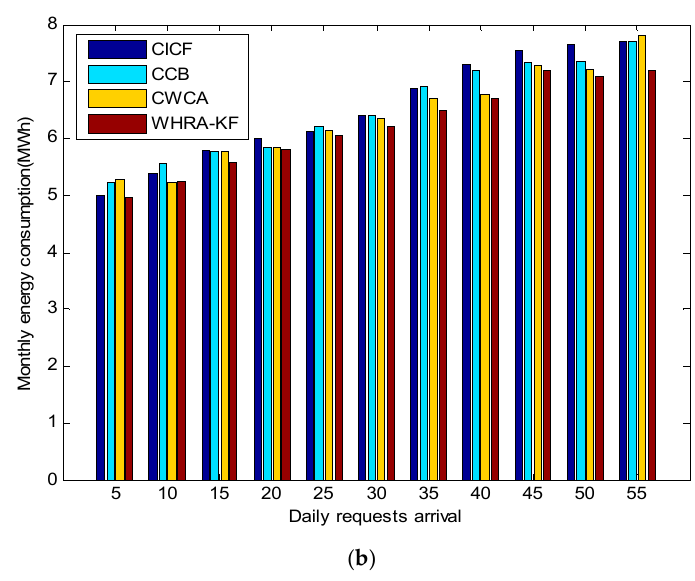
Figure 15. Comparison of the energy consumption for the four recommendation algorithms, ( a ) Different scheduling cycle; ( b ) Different daily requests arrival.